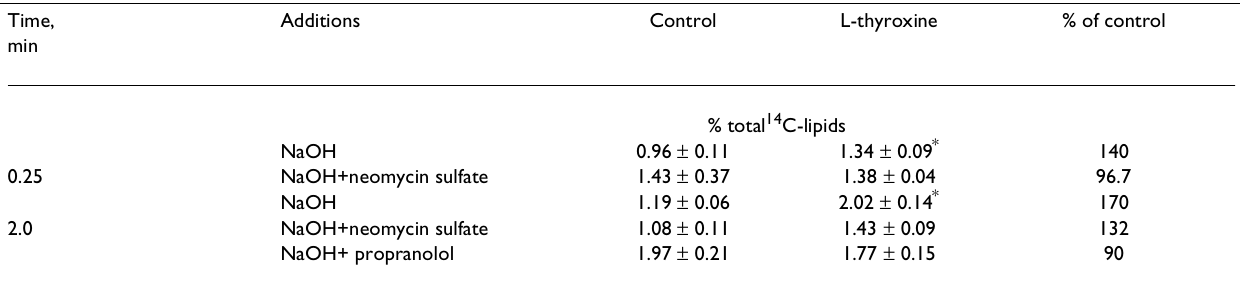
Table 1: Effect of neomycin sulfate and propranolol on the L-T 4 -induced DAG formation in [ 14 ]oleic acid pre-labeled hepatocytes. Time,